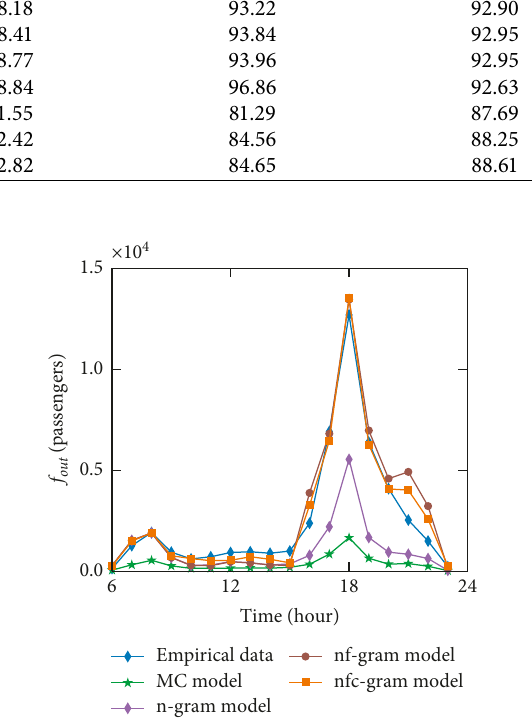
Figure 5: The hourly out-passenger flow at the crowding station.